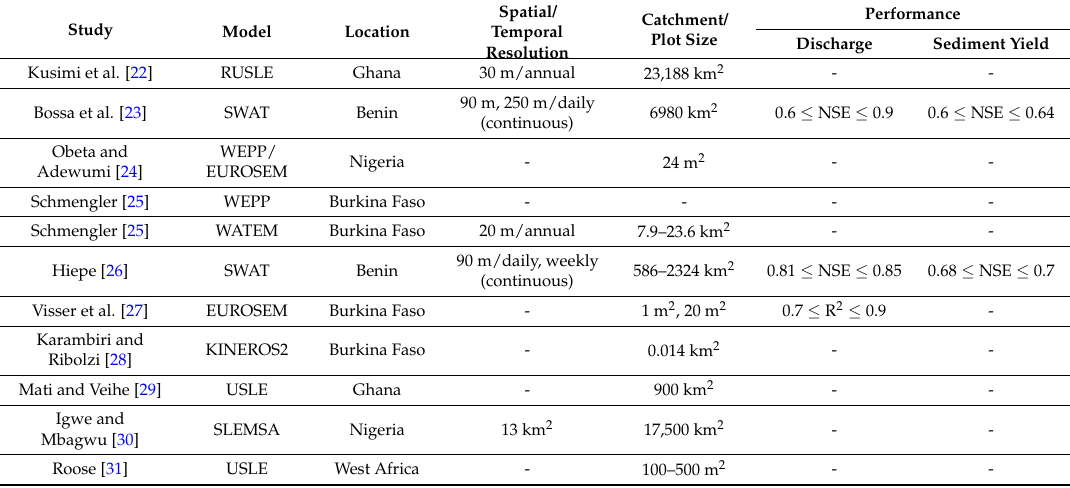
Table 1. Selected studies on soil erosion modelling in West Africa. NSE is the Nash-Sutcliff efficiency. Study